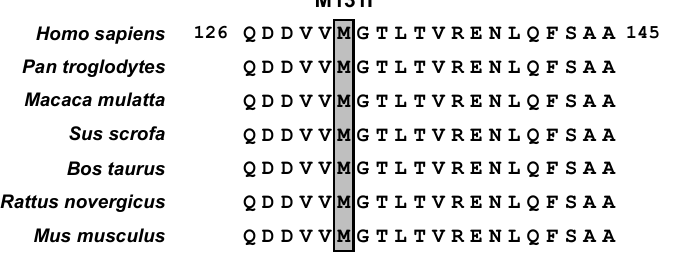
Figure 3. ABCG2 M131 is shown to be evolutionary conserved among seven mammalian species. Regarding the Abcg2 protein in each species, the NCBI Reference Sequence IDs are summarized as Pan troglodytes (Chimpanzee), GABE01009237.1; Macaca mulatta (Rhesus macaque), NM_001032919.1; Sus scrofa (Pig), NM_214010.1; Bos taurus (Bovine), NM_001037478.3; Rattus norvegicus (Rat), NM_181381.2; Mus musculus (Mouse), NM_011920.3. Multiple sequence alignments and homology calculations were carried out using GENETYX software (GENETYX, Tokyo, Japan) and the ClustalW2.1 Windows program, per the protocol used in our previous study